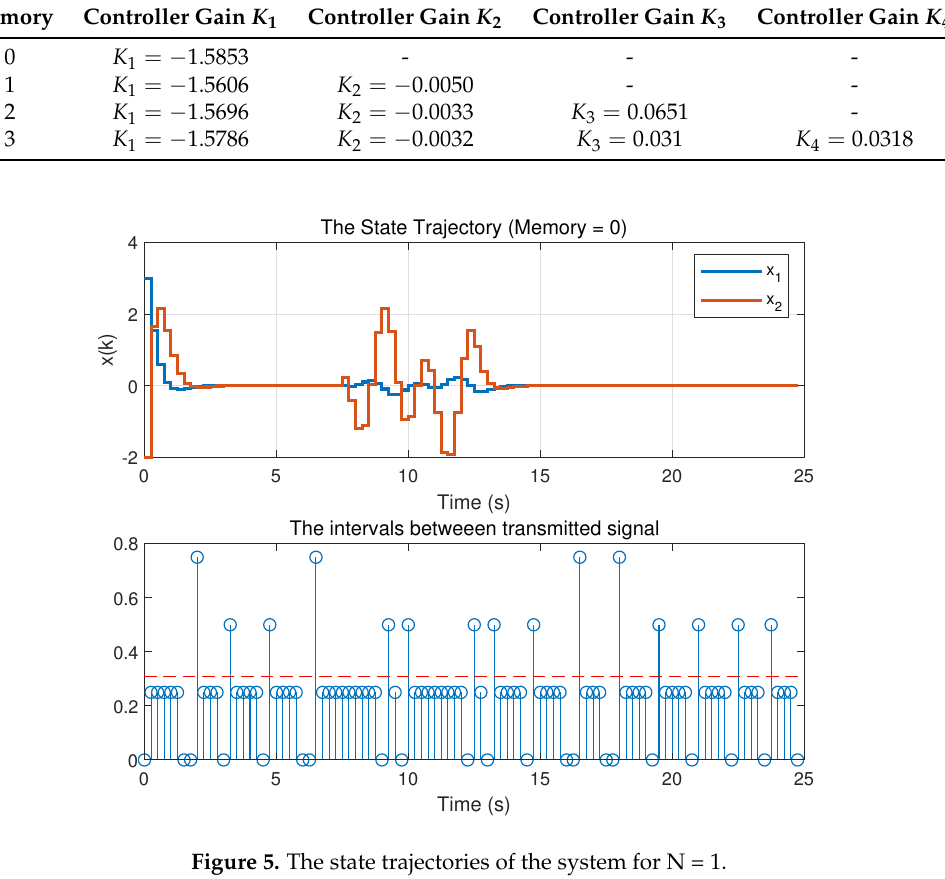
Figure 5. The state trajectories of the system for N = 1.